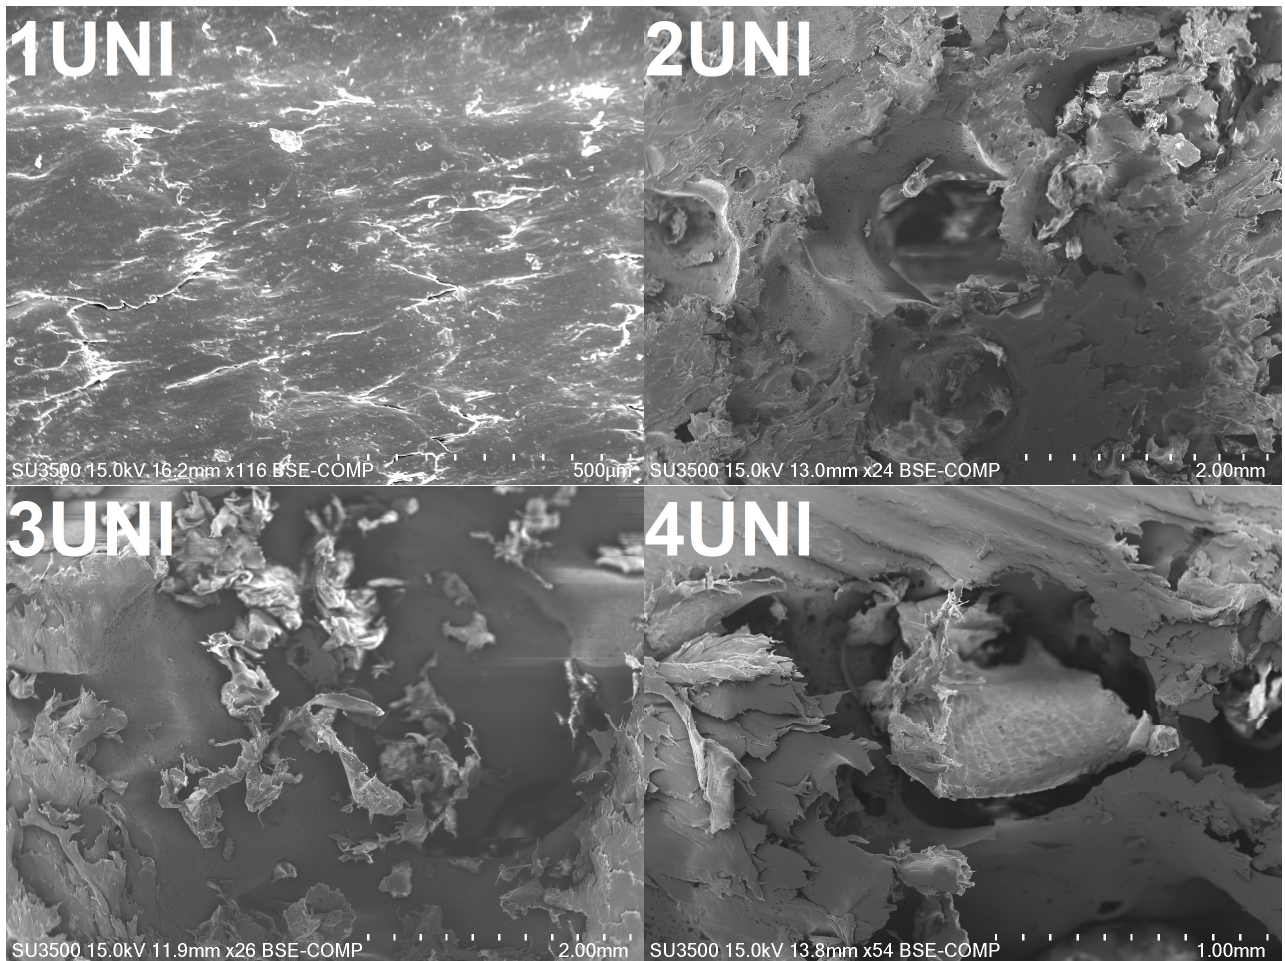
Figure 8. Magnified SEM images of selected samples showing interfacial defects.